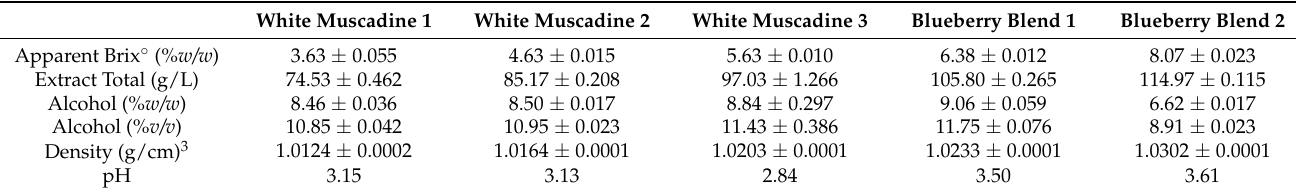
Table 1. Physical characteristics (sugar content, alcohol level, and density) of five Florida white muscadine and blueberry wines as determined using an Anton Paar ALEX 500 with mean ± standard deviation from triplicate trials. The pH was assessed using a Fisher scientific AB15 pH